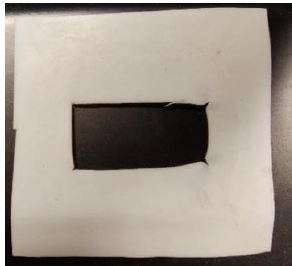
Figure 6. Damaged PTFE mold compressed under 44,480 N at 227 °C.